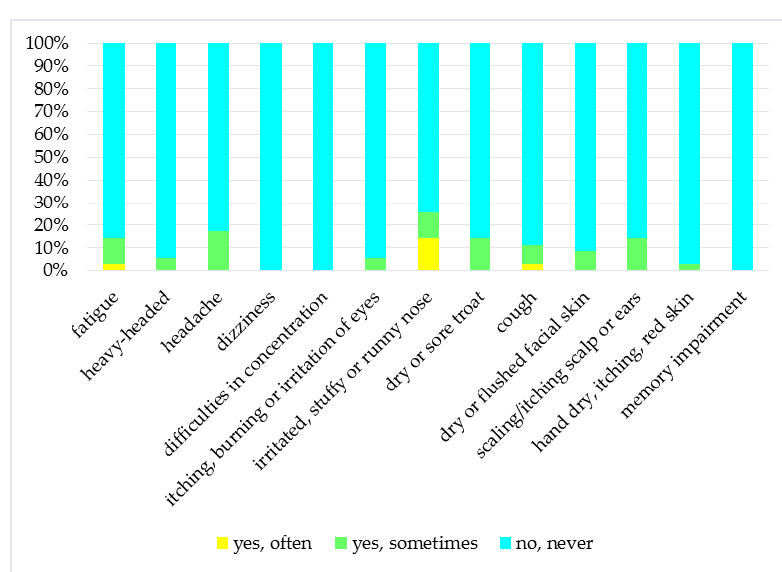
Figure 3. Prevalence of SBS symptoms.